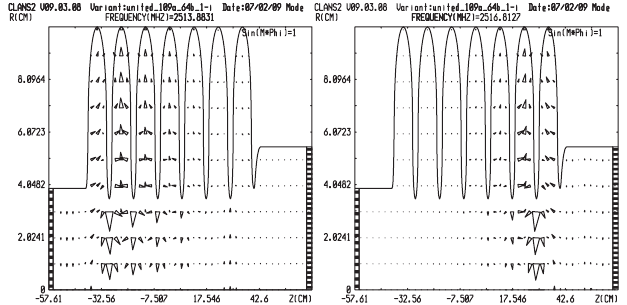
FIG. 25. Redirection of modes with maximal @p=@q into different pipes.